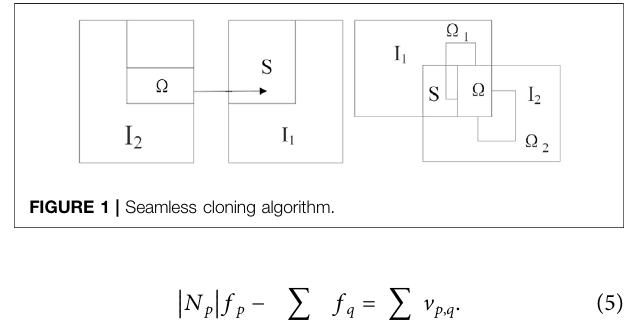
FIGURE 1 | Seamless cloning algorithm.